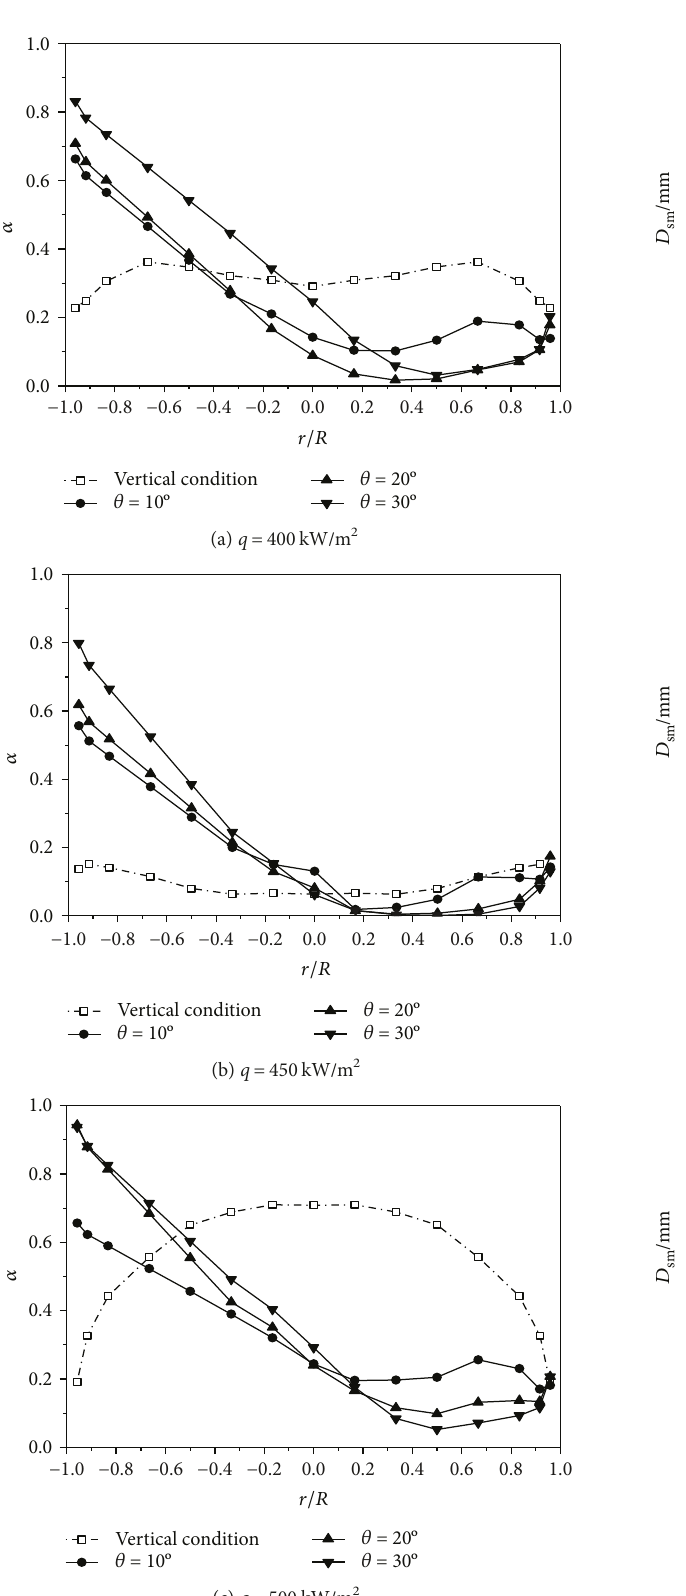
Figure 6: Inclination angle e ff ect on the local void fraction on the direction of β = 90 ∘ in cross section ( P = 0 5 MPa, G = 500 kg/m 2 s).